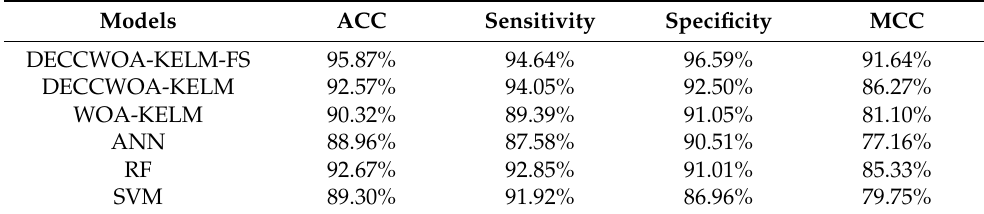
Table 7. Four avg metrics results of the proposed model and other models.